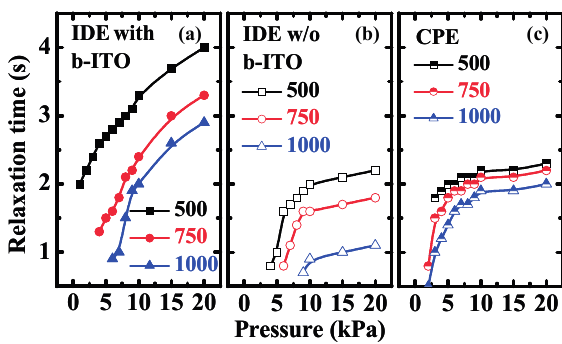
Figure 9. Relaxation time versus pressure characteristics of the pressure sensors with ( a ) inter-digitated electrode (IDE) with bottom indium-tin-oxide (b-ITO); ( b ) IDE without b-ITO; and ( c ) cross-point electrode (CPE) structures under the pressure of 0.1 to 20